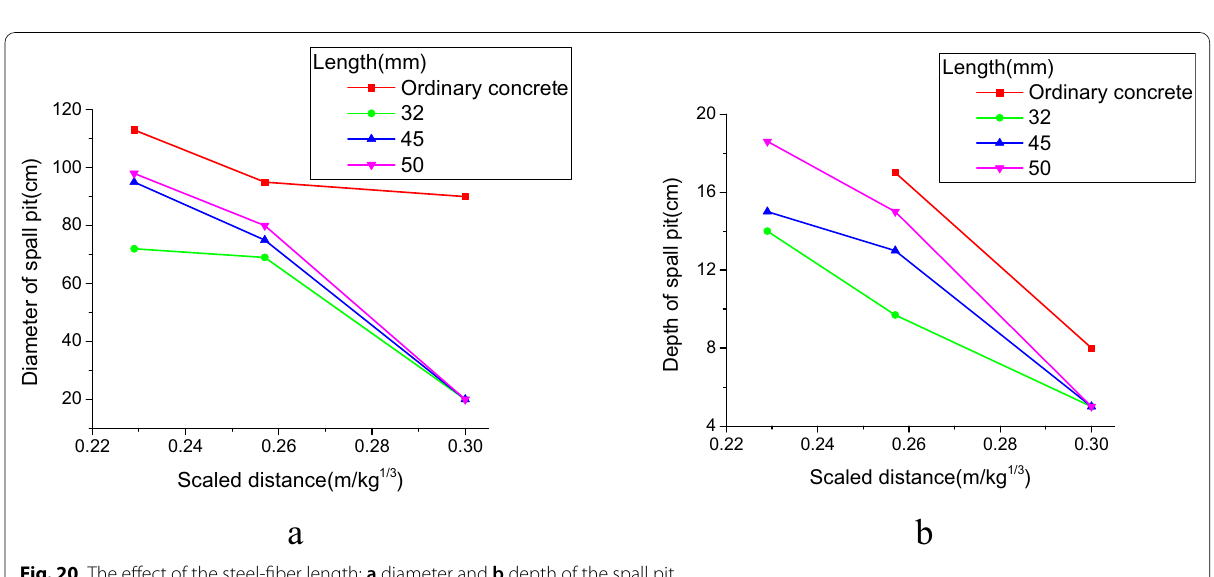
Fig. 20 The effect of the steel-fiber length: a diameter and b depth of the spall